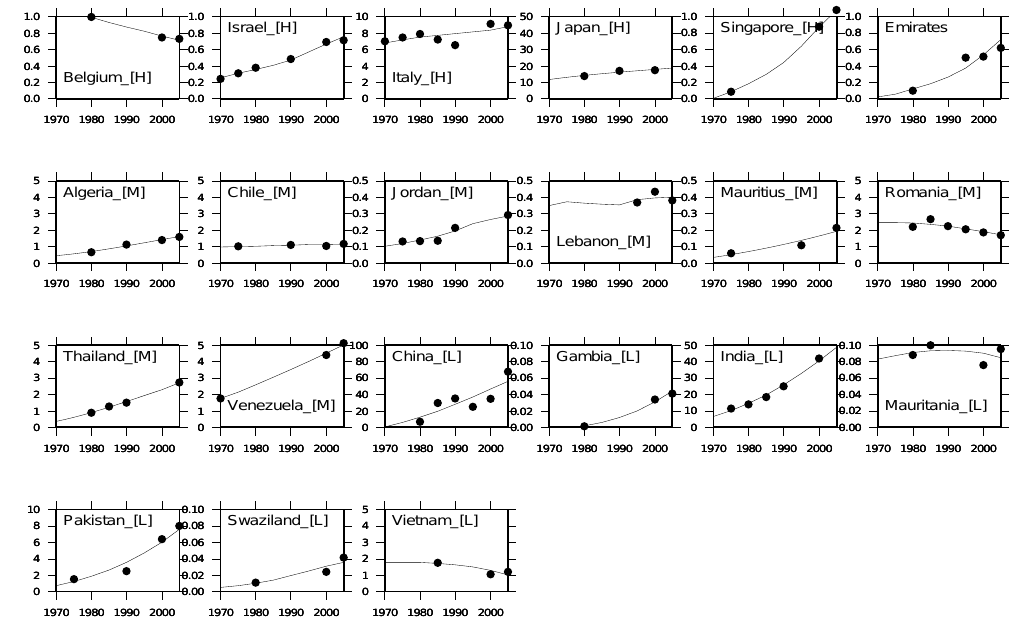
Fig. 8. Historical records of national municipal water withdrawal (plot) and estimations with Eq. (5) (line) (km 3 yr − 1 ) . Table 8. Scenarios for municipal water intensity change (Lperson − 1 day − 1 yr − 1 ) . High efficiency (HE) Medium efficiency (ME) Low efficiency (LE) per capita GDP <